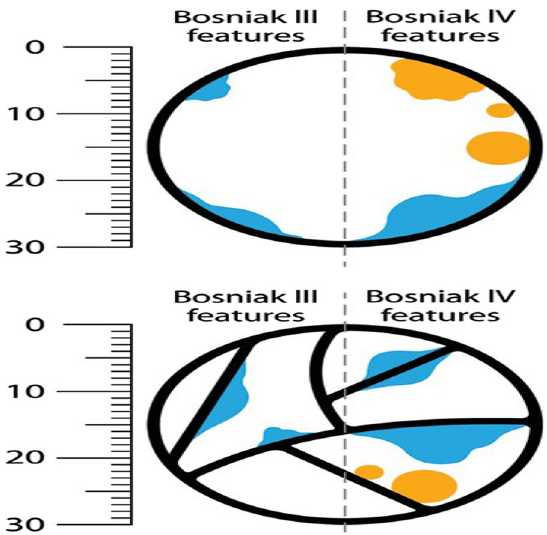
Fig. 1 Differentiation between wall and septa irregularity from nodules by using the Bosniak classification of cystic renal masses, version 2019. Orange features have acute margins and blue features have obtuse margins. Bosniak III features are examples of focal irregular thickening. Bosniak IV features are examples of nodules